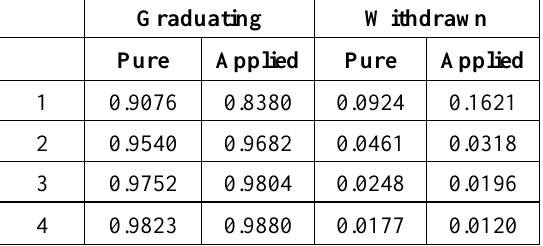
Table 11. Probability of reaching the graduating and withdrawn states by academic